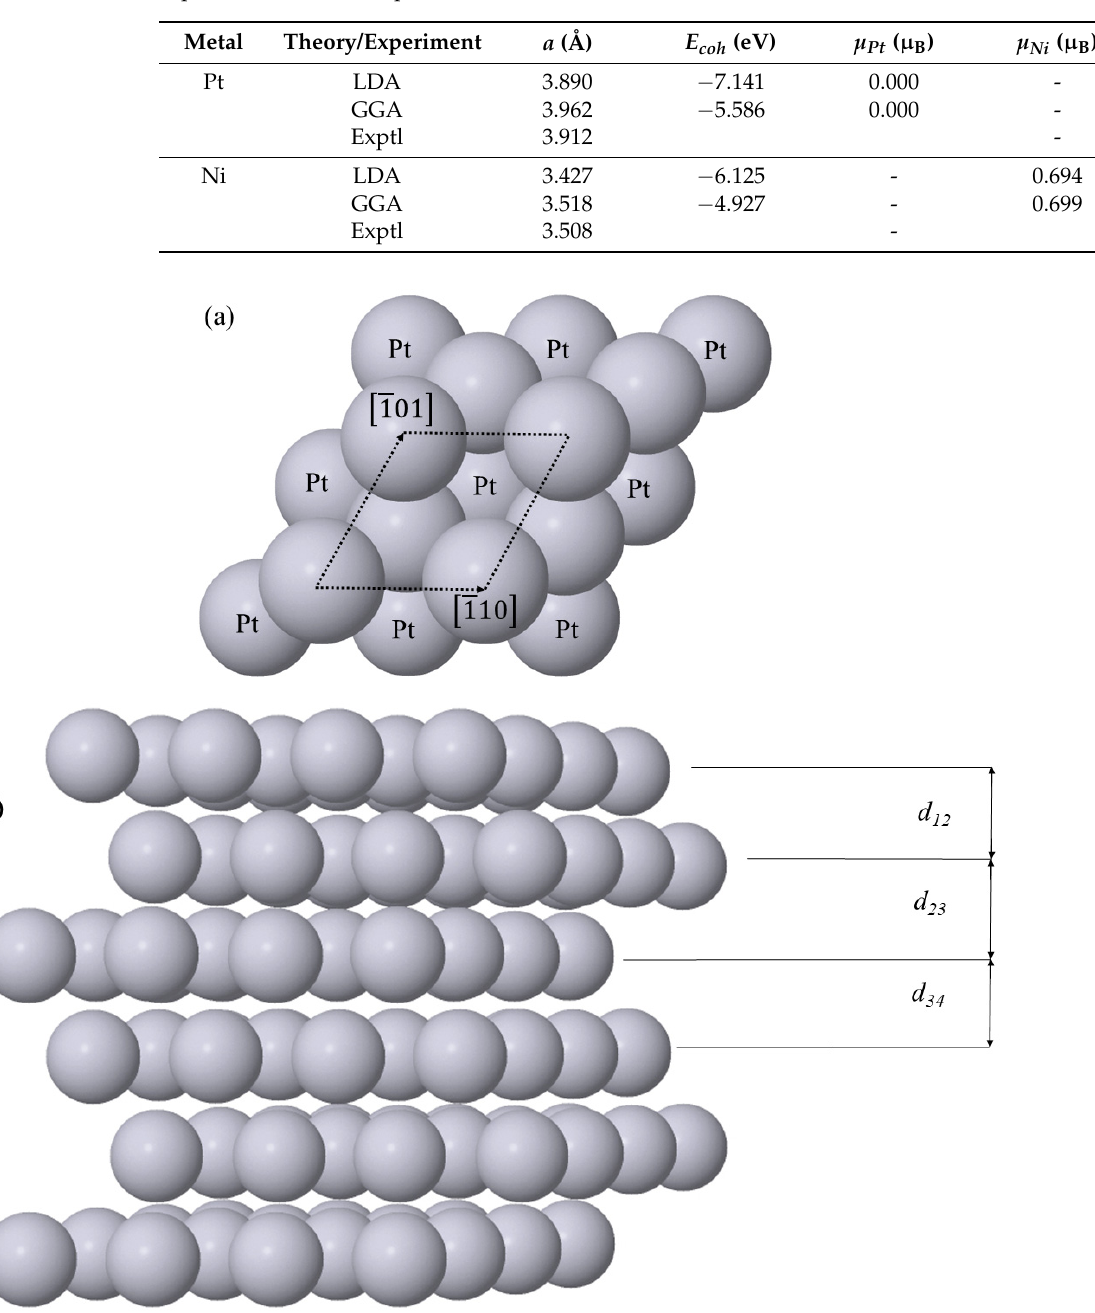
Table 1. The bulk lattice parameters a , cohesive energies E coh and magnetic moments µ Pt and µ Ni for the bulk Ni and Pt metals. Cohesive energies are at the minima in the equations of state shown in Figure 2. The ‘Theory/Experiment’ column shows the exchange-correlation functional used (LDA/GGA) in the case of theoretical estimates of each of the physical parameter or shows the experimental value (‘Exptl’) where available.